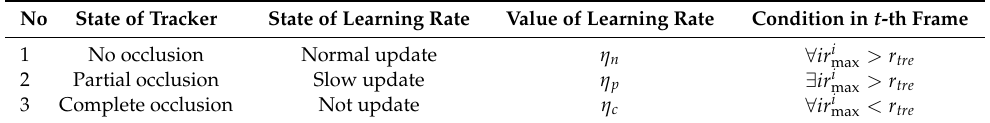
Table 1. Three different update